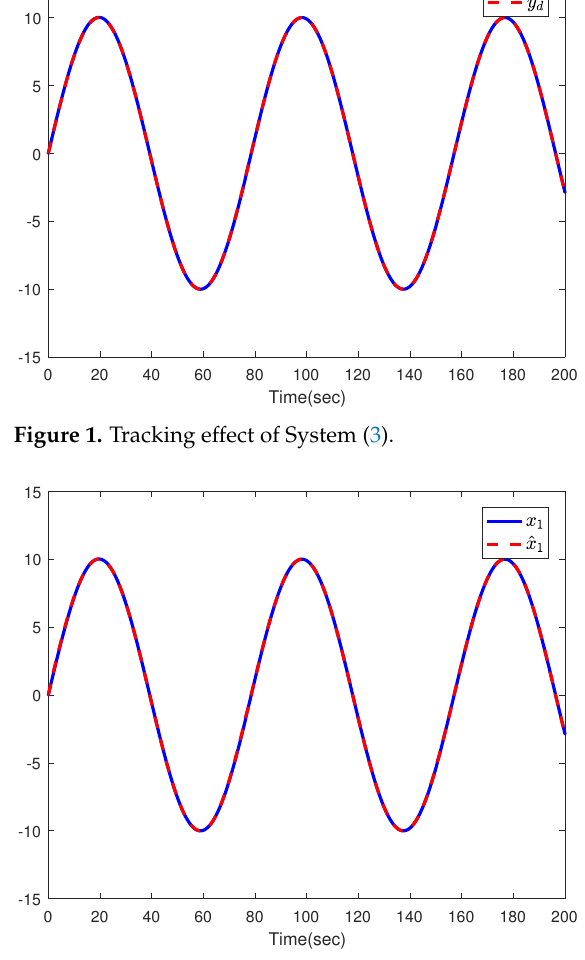
Figure 2. Responses of states x 1 and ˆ x 1